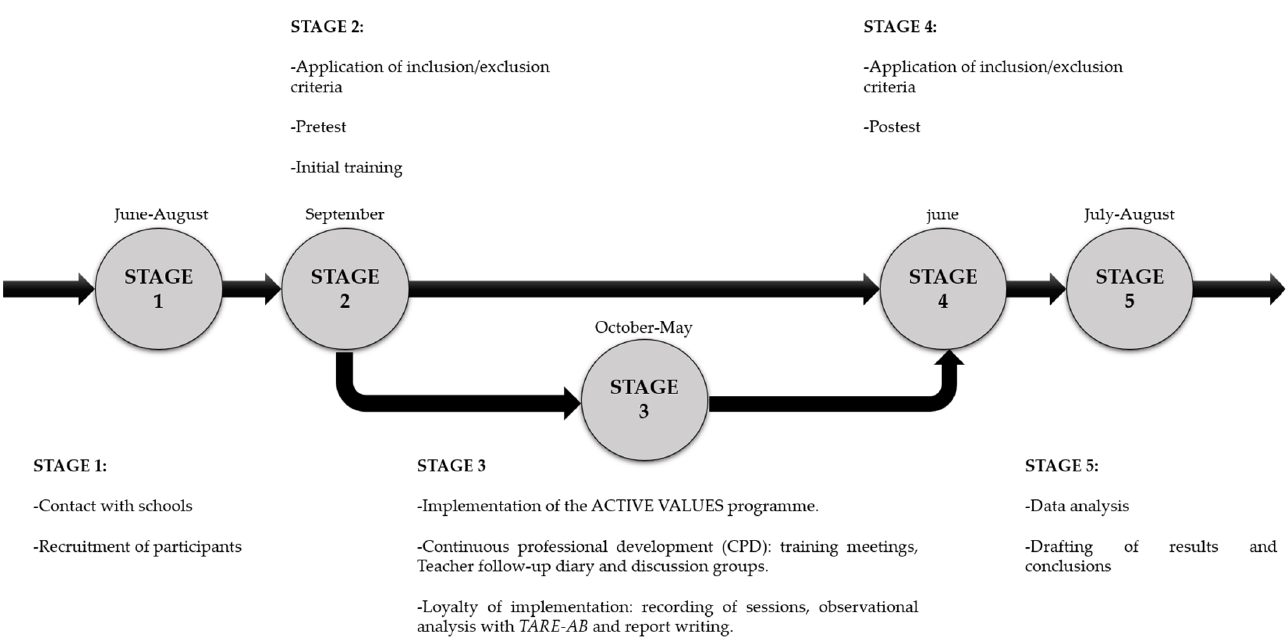
Figure 2. Stages into which the timetable of this intervention protocol is divided.